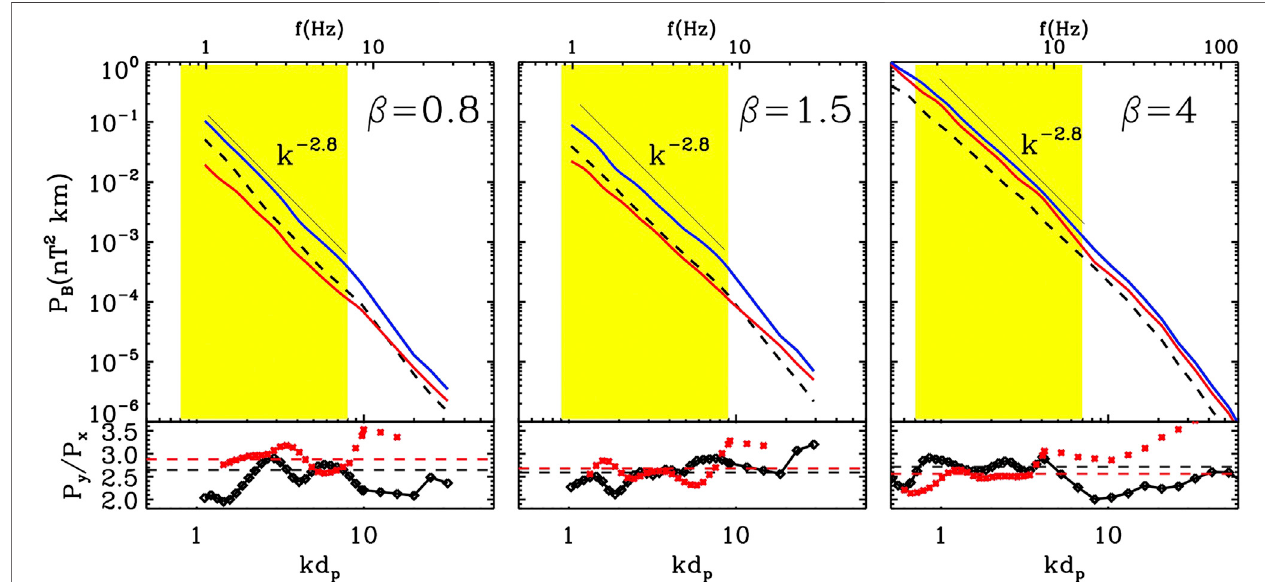
FIGURE 1 | Cluster STAFF spectra for different intervals with β (cid:2) 0 . 8 , 1 . 5 , 4 from left to right. Colors encode the magnetic fi eld components B x (black dashed), B y (blue), and B z (red). The region highlighted in yellow corresponds to the sub-ion range investigated in this study. Bottom panels show the ratio of the power in the perpendicular components P y ( k ) / P x ( k ) (black diamonds) and the value γ of the local slope of the total spectrum P ( k ) ∼ k − c (red stars). The average values of P y ( k ) / P x ( k ) and γ in the sub-ion range are also shown as horizontal dashed lines.